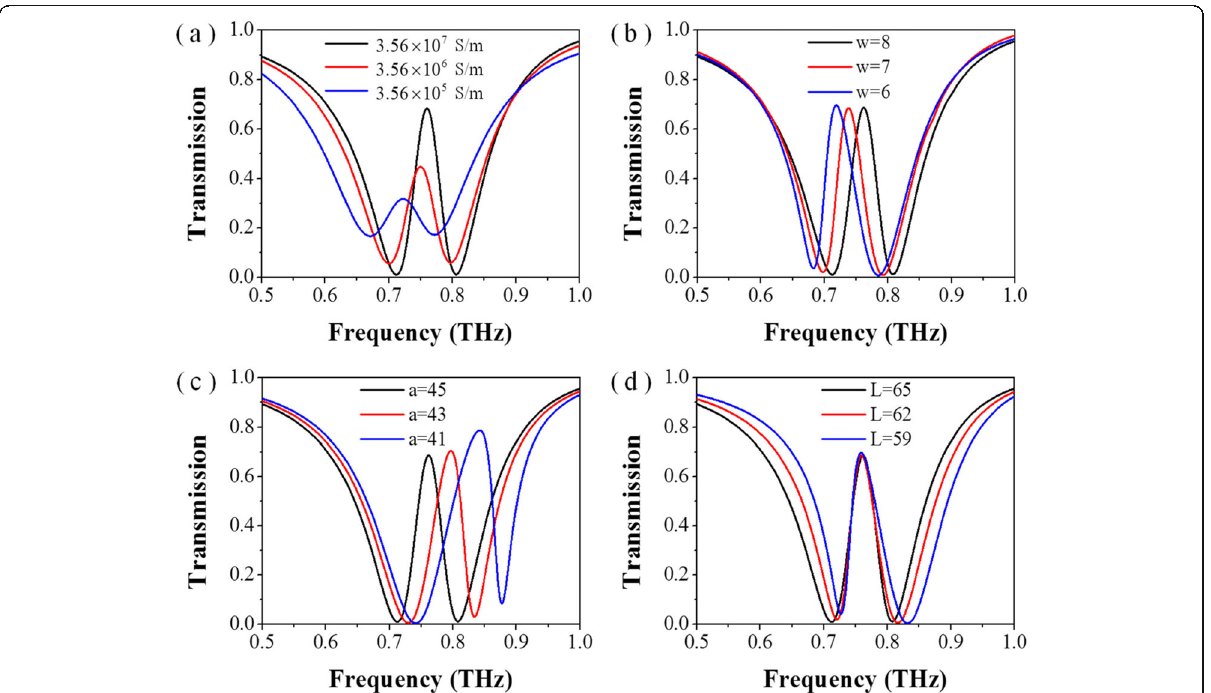
Fig. 4 Simulated spectra of the conductively coupled terahertz metamaterial with various structural parameters of a conductivity of aluminum; b the line width of the aluminum strips and SRRs; c the length of the square SRR; d the length of the aluminum